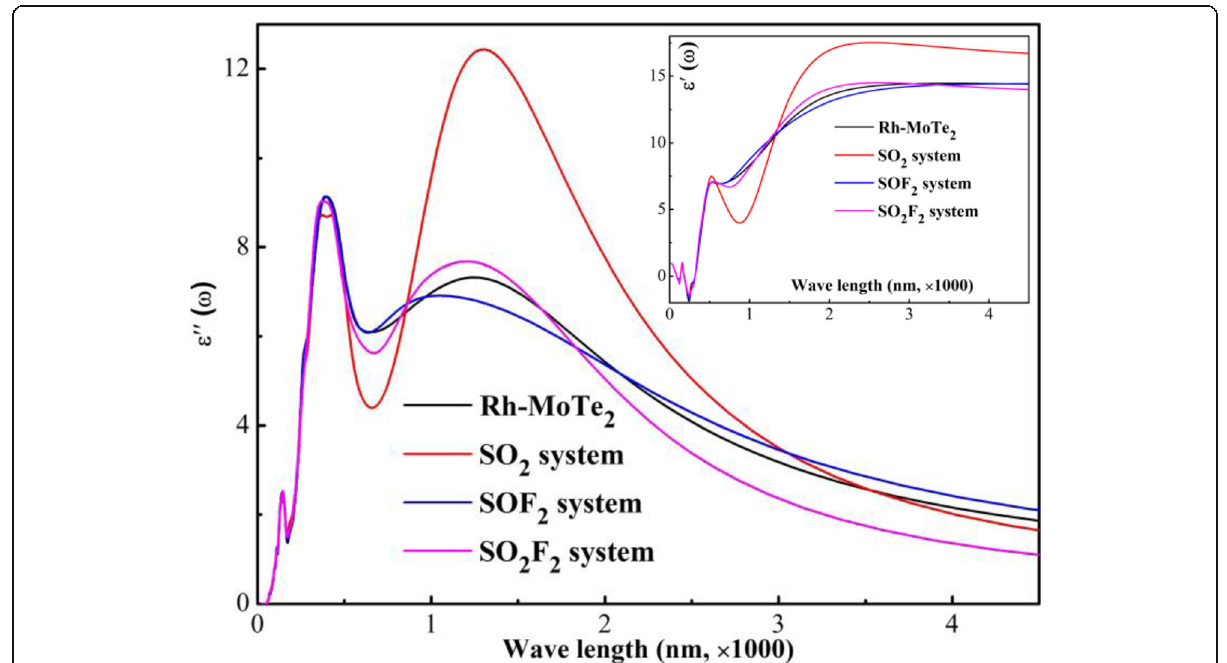
Fig. 9 Dielectric function of Rh-MoTe 2